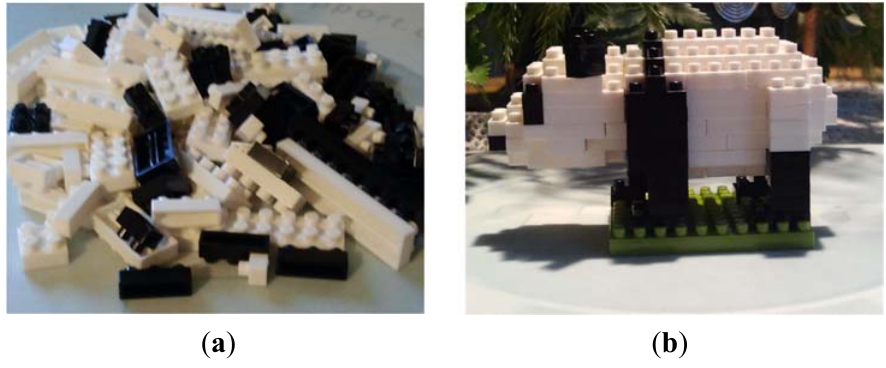
Figure 5. ( a ) a pile of Lego-like blocks; ( b ) a structure created from the